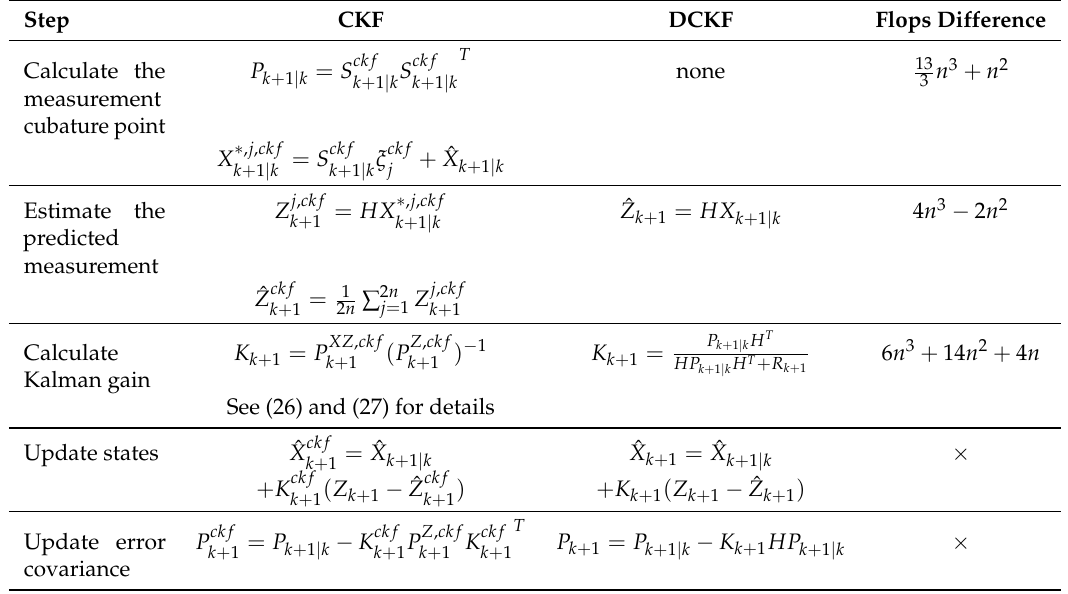
Table 2. Comparison of cubature Kalman filter (CKF) and derivative cubature Kalman filter (DCKF) computational